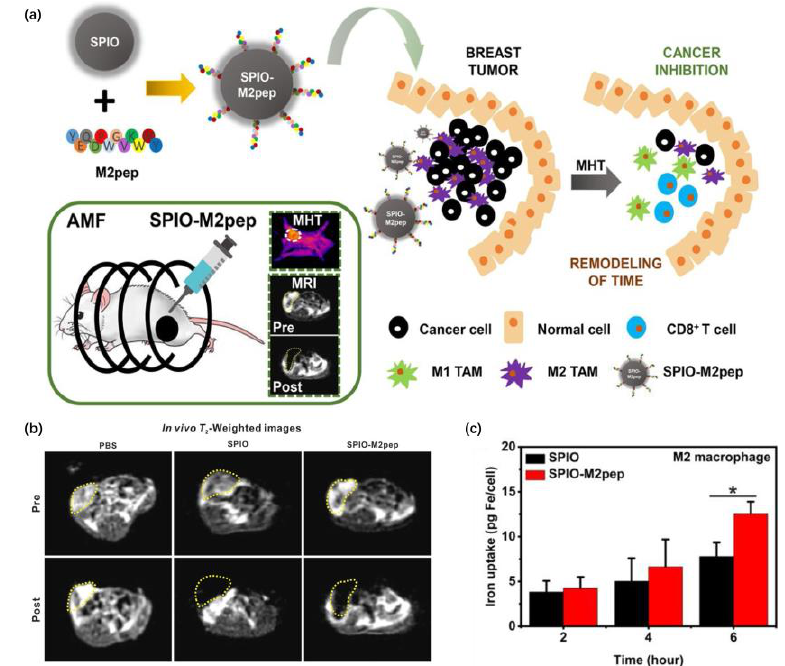
Figure 2. ( a ) Schematic of the preparation of SPIO-M2pep and the mechanism of SPIO-M2pep in M2 TAM-targeted and MRI-guided magnetic hyperthermia therapy of breast cancer. ( b ) MR imaging of orthotopic breast tumor mice before and 30 min after injection of SPIO or SPIO-M2pep (tumor: yellow dashed line) ( c ) Iron uptake in M2 macrophage cells treated with SPIO and SPIO-M2pep for different incubation times (25 µ g mL − 1 , n = 3). p values less than 0.05 are considered significant and marked with * [19]. Copyright 2021,